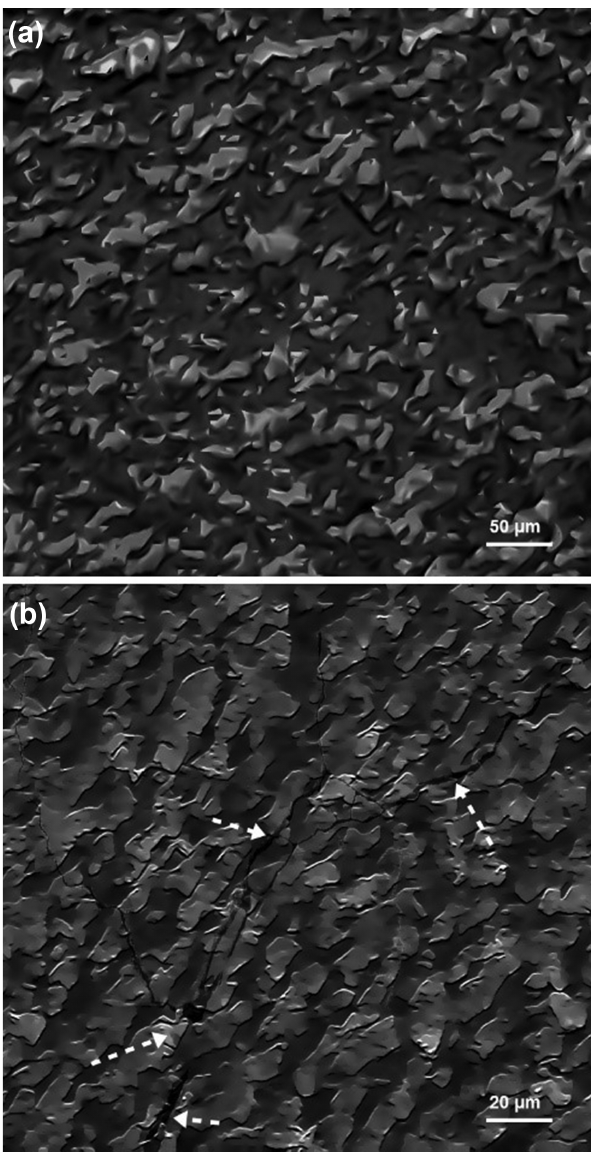
Figure 9: SEM images of the fracture surfaces for MgAl 2 O 4 -Y 3 Al 5 O 12 eutectics after the tensile tests (a) at 1,200°C, and (b) at 1,500°C. The bright areas are Y 3 Al 5 O 12 and the dark areas are MgAl 2 O 4